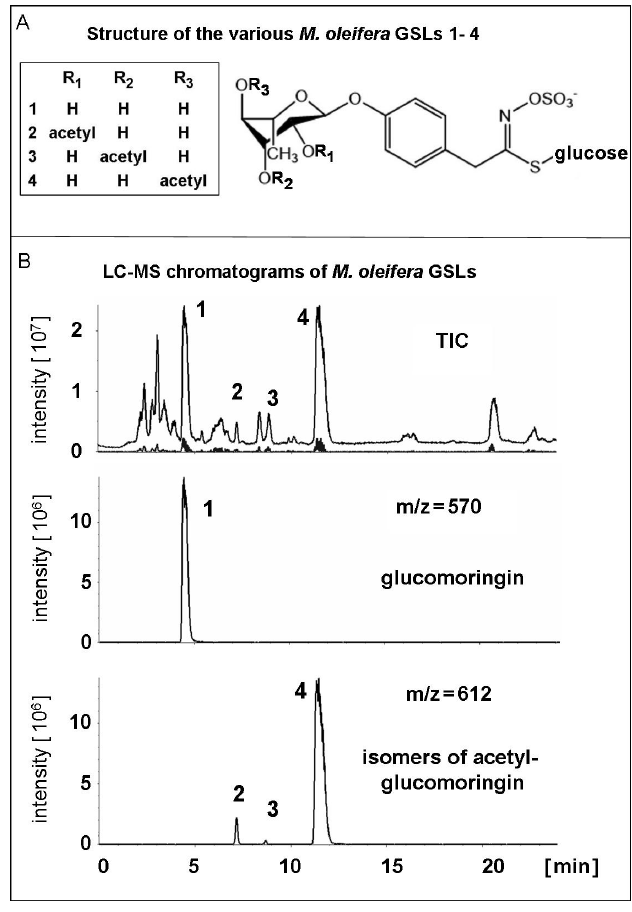
Fig. 3: Glucosinolates present in M. oleifera